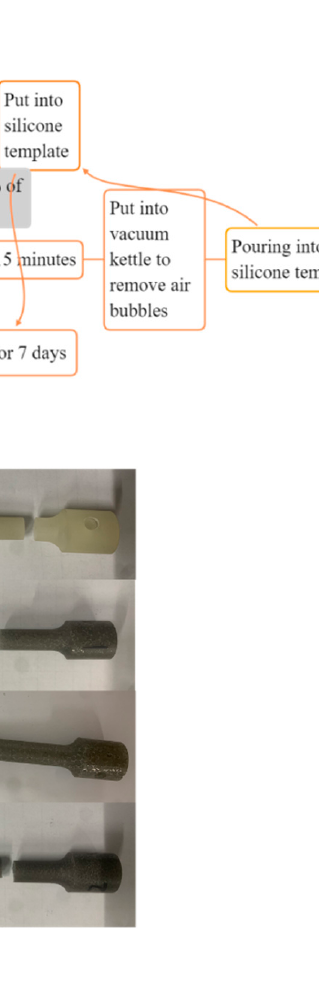
Figure 7. Diagram of tensile loading process of foam Ni-Fe/epoxy composite: ( a ) original specimen; ( b ) damaged specimen.